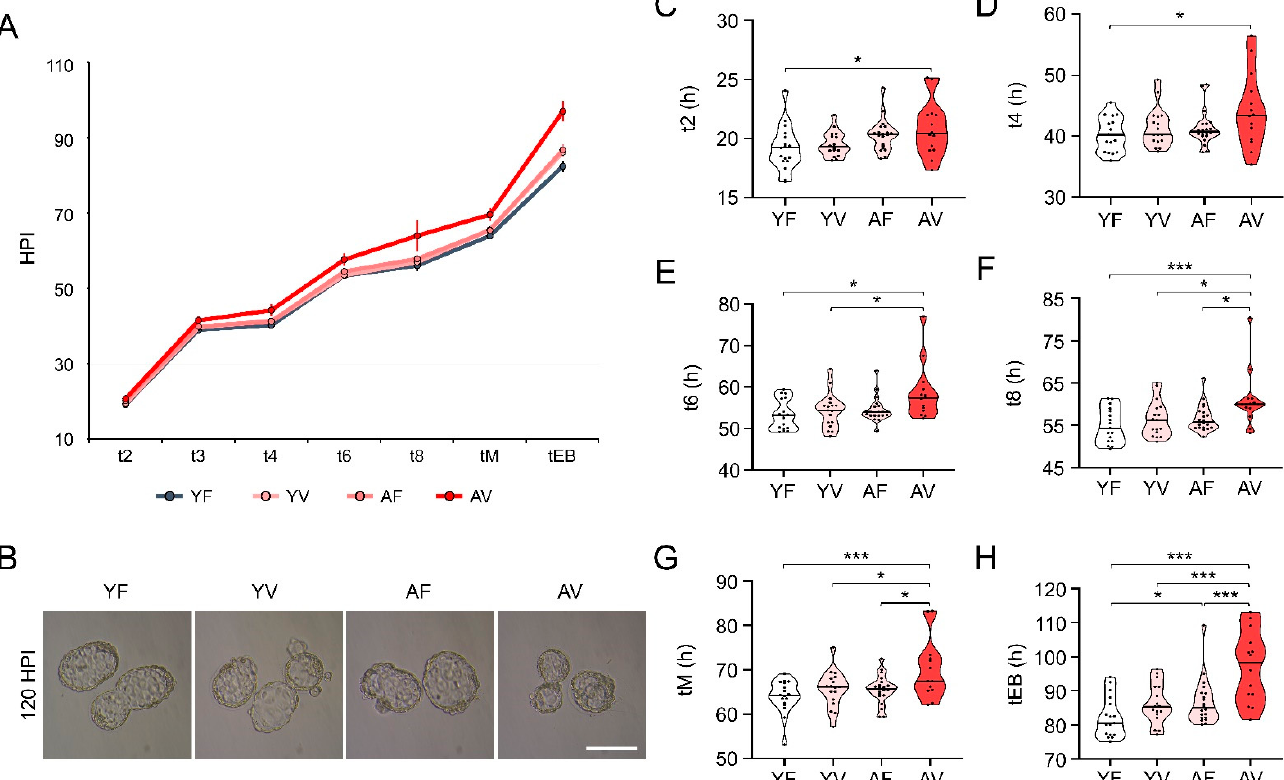
Figure 6. Comparison of embryo morphokinetics of fresh and vitrified/warmed (VW) oocytes from young and aged mice. ( A – H ) Comparison of morphokinetics of embryos developed from oocytes from young and aged mice after vitrification ( n = 14–20 oocytes in each group). t2, t3, t4, t6, t8: time in hours post insemination (HPI) for the embryo to reach the 2-, 3-, 4-, 6-, 8-cell stage, respectively, tM: time for compaction, tEB: time for the embryo to start blastocoel formation. Statistical comparisons were performed using student’s t -test. Four independent experiments were performed with similar results. * p < 0.05, *** p < 0.005. Scale bar = 140 µm. YF: Young fresh, YV: Young vitrified, AF: Aged fresh, AV: Aged vitrified.